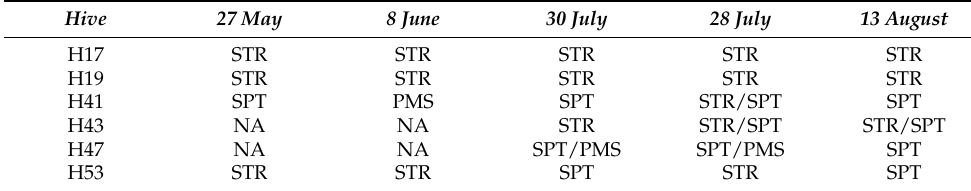
Brood quality measurements in monitored hives; STR—straight; SPT—spotty; PMS—parasitic mite syndrome; NA—not available; colonies with PMS have white larvae that appear chewed or sunken on the side of the